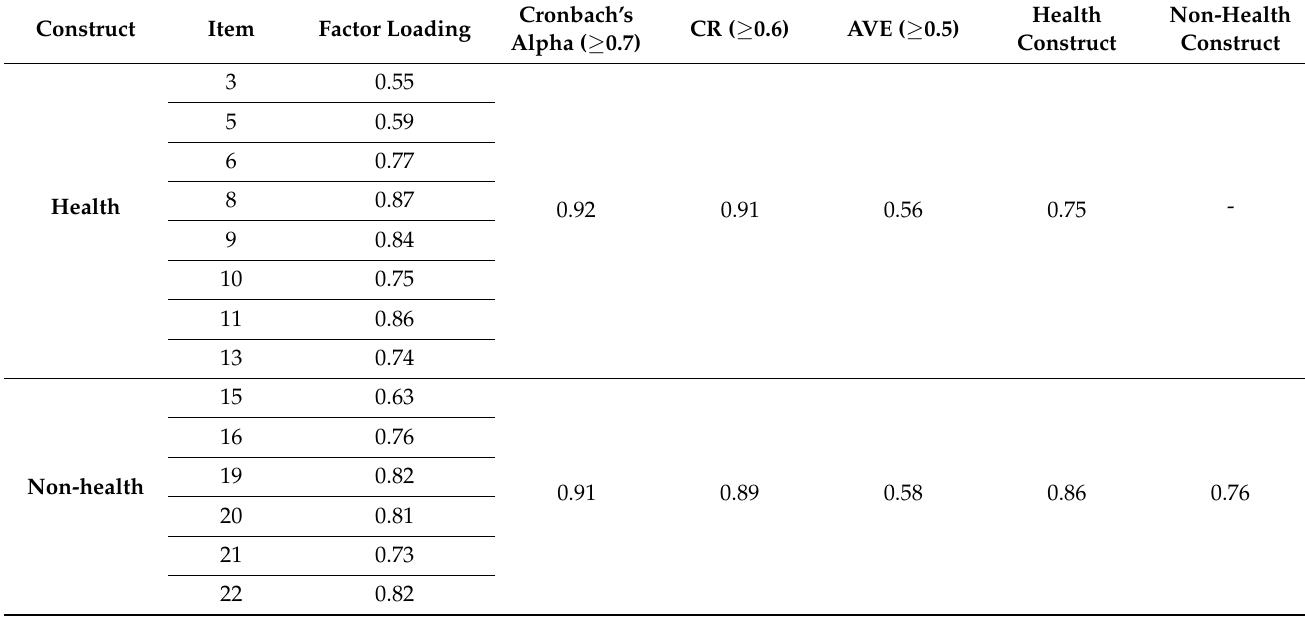
Table 6. The CFA validity and reliability results for the final